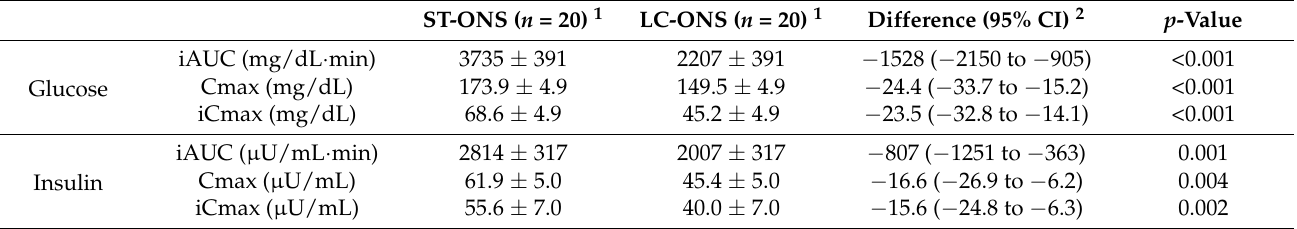
Table 3. Area under curve (AUC), maximal value (Cmax), and incremental maximal value (iCmax) of glucose and insulin after consumption of the test products.